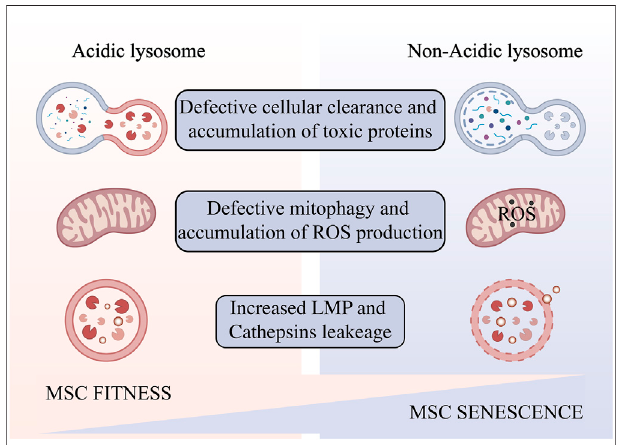
FIGURE 2 | Impaired lysosomal acidi fi cation occurs in aging MSCs ampli fi ed in vitro . Lysosomal alkalinization leads to reduced autophagic fl ux andaccumulationoftoxicproducts,resultinginoxidativestressandincreased lysosomal permeability, and ultimately cell senescence and death. Created with